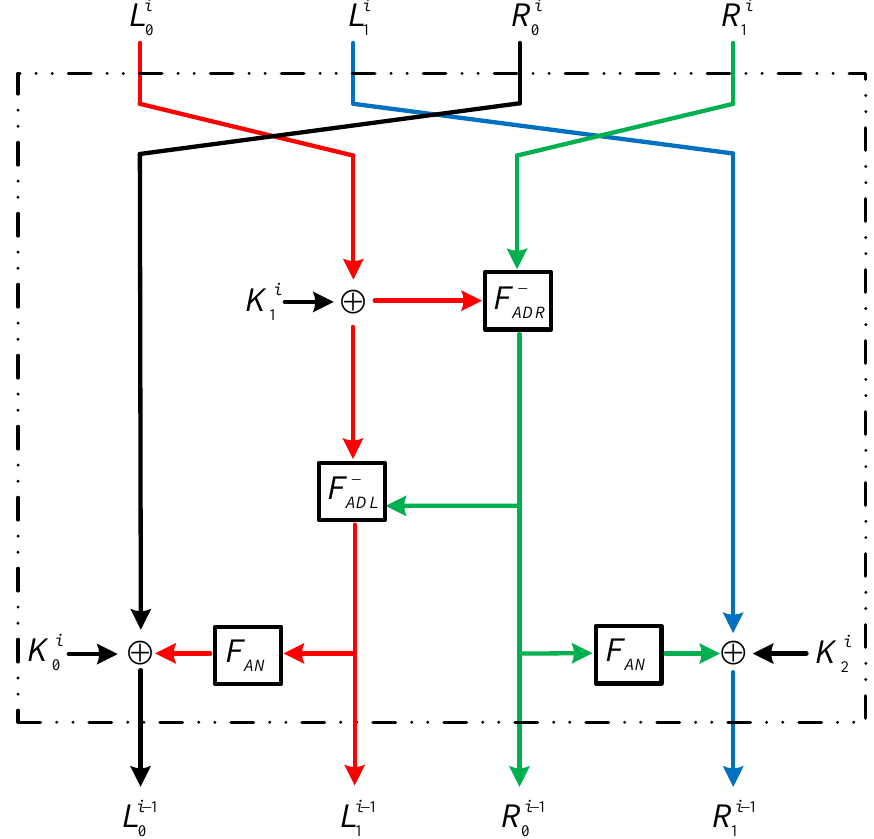
Figure 6. The i -th round decryption process of the GFRX